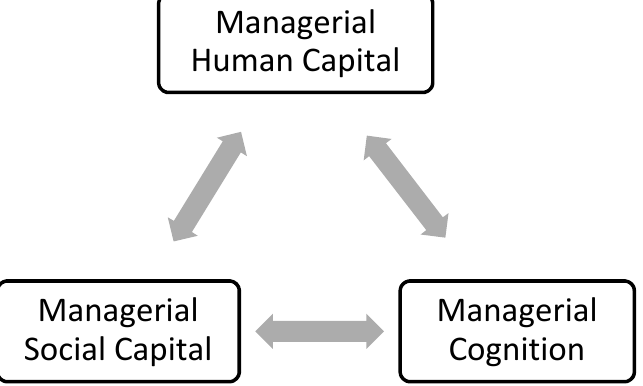
Figure 1. Linkages among the roots of managerial capabilities [12] (p. 1022).